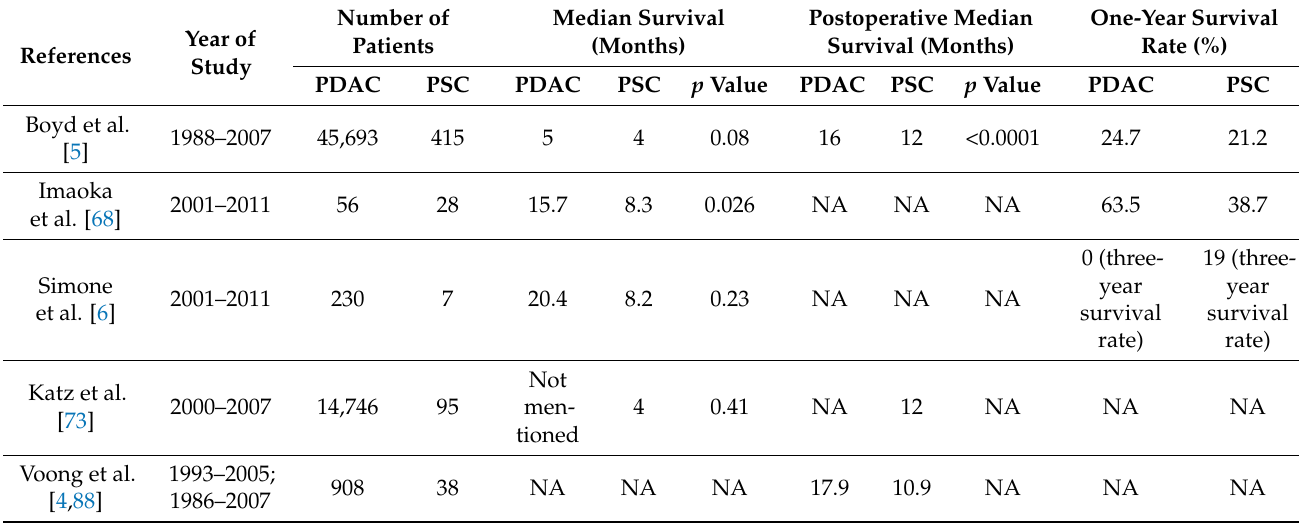
Table 2. The comparison of outcomes between PSC and PDAC from published